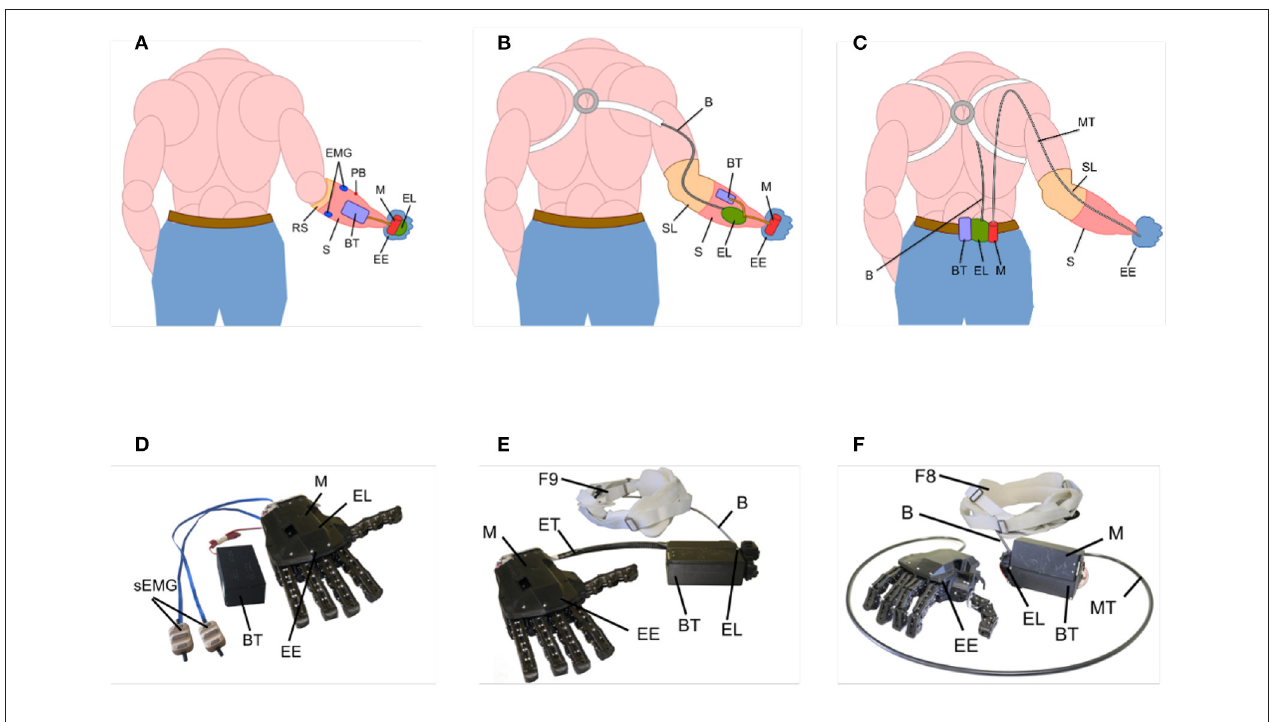
FIGURE 4 | Schematic placement ( A–C ; Benchmark, Compact, and Hardy Configurations, respectively) of the components of the configurations tested in this study on the hand, socket, and waist of the user and pictures (D–F) of the physical devices used. EE, Prosthetic Device; S, Socket; RS, Rigid Socket; SL, Soft Socket Liners; B, Cable Control System; EMG, Surface Electromyographic Sensors; M, Motors; EL, Electronic Boards; BT, Battery Pack; PB, Power Button; BT, Battery Pack; ET, Electrical Transmission Cable; MT, Flexible Transmission Shaft; F8, Figure-of-eight Harness; F9, Figure-of-nine